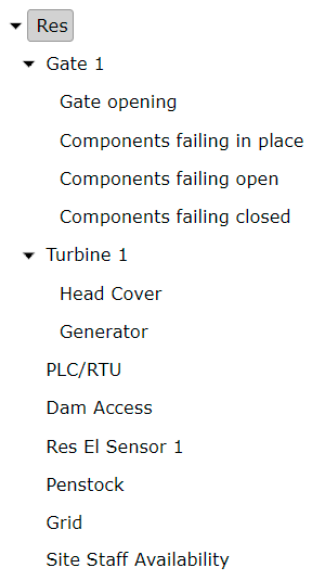
Figure 14. Components tree for simple dam system.